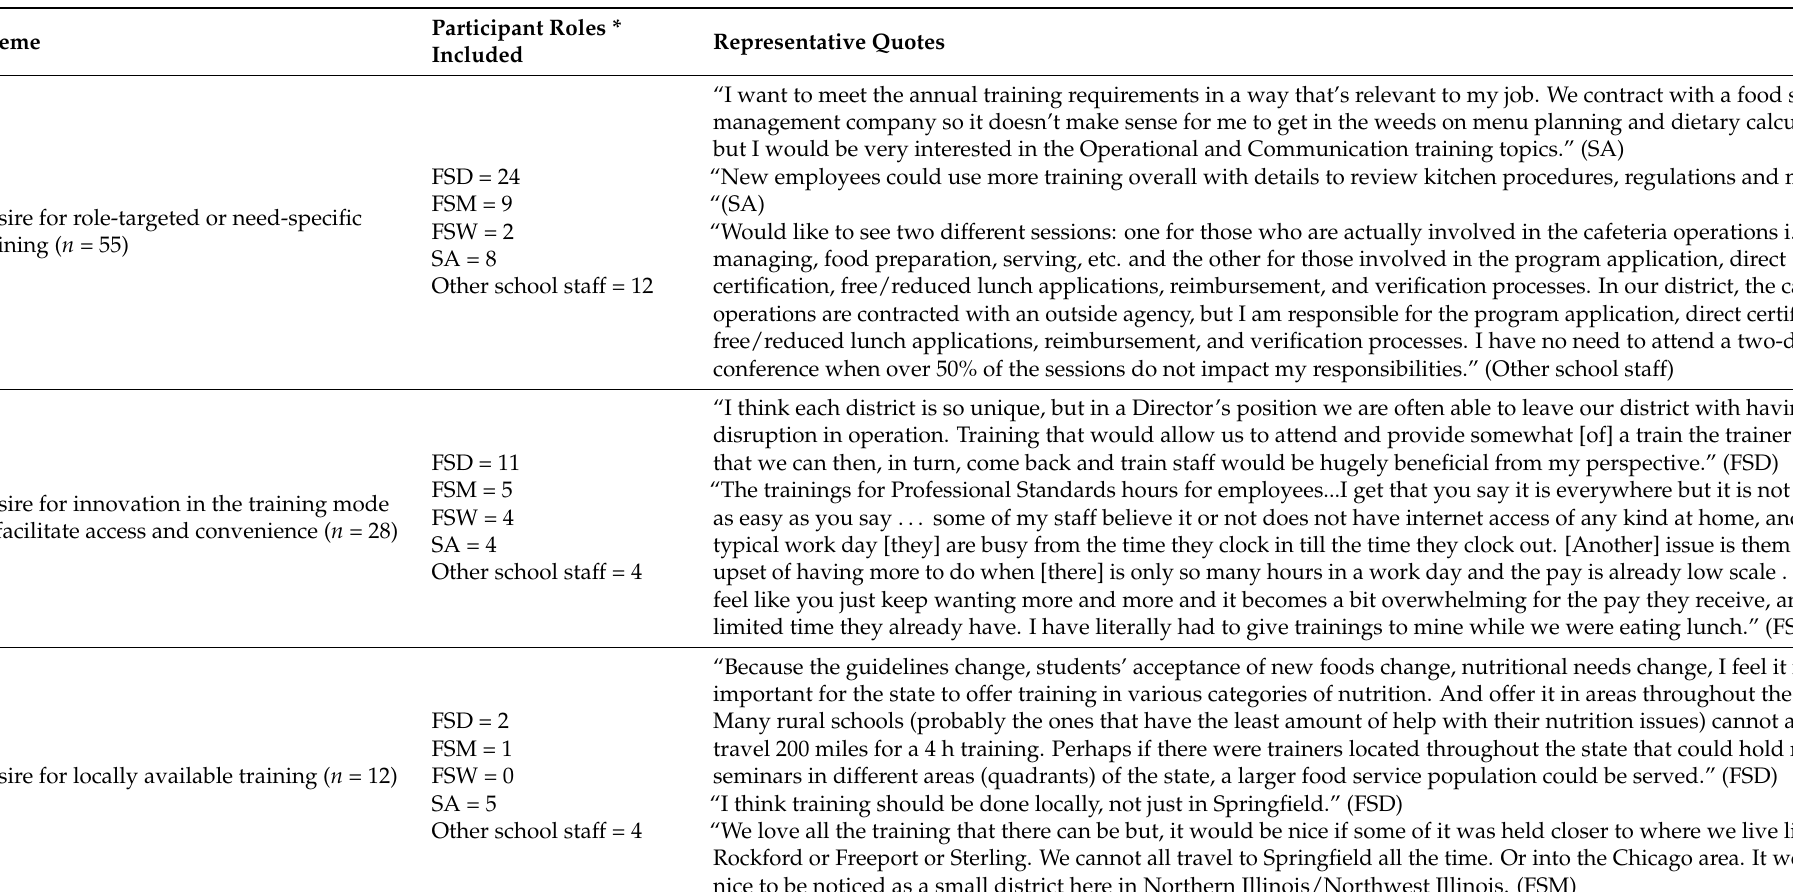
Table 4. Qualitative analysis findings of the open-ended survey question ( n = 93) 1 . Theme